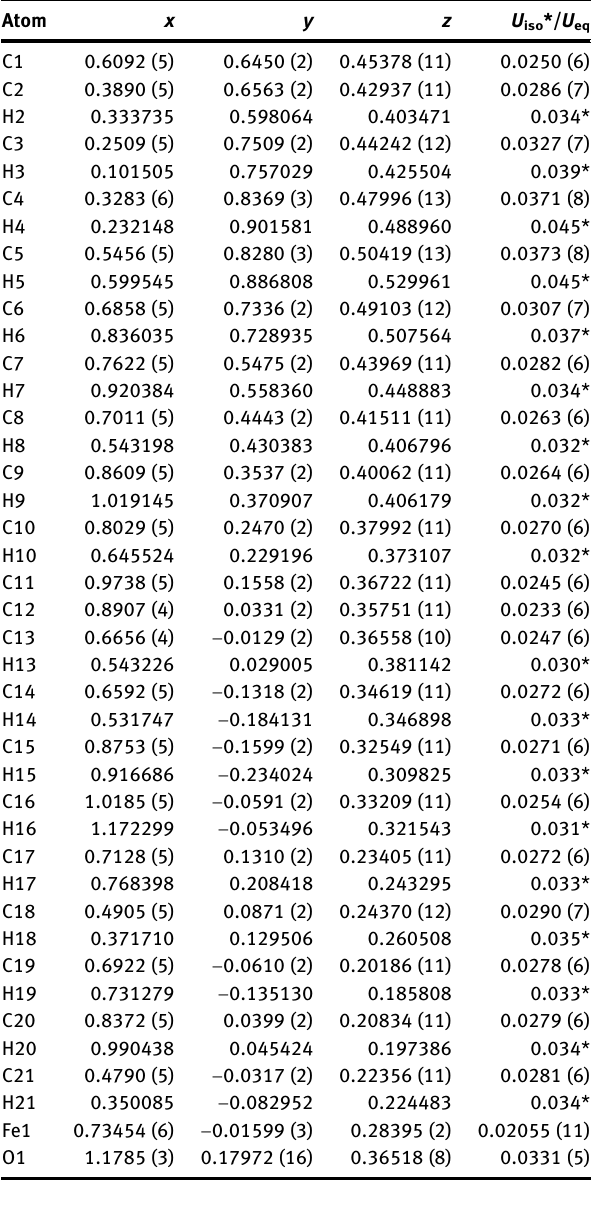
anti-bacterial [7], anti-tubercular, anti-oxidant [8], insecti- cidal, anti-cancer, anti-in fl ammatory [9], anti-microbial [10], anti-angiogenic [11], and immunomodulatory properties